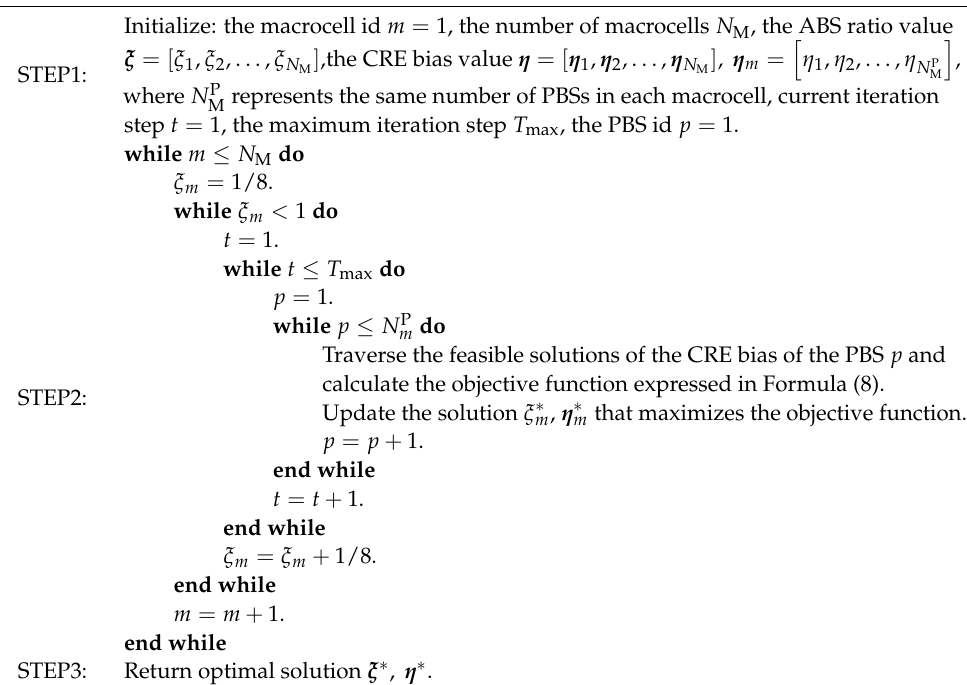
Algorithm 2 Joint Optimization Algorithm of Adaptive CRE and